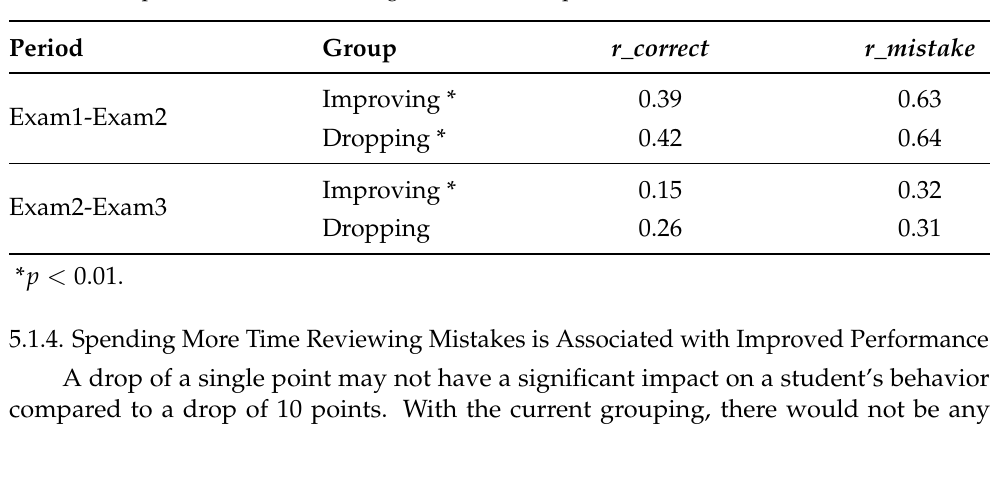
Table 4. Comparison of review coverage across the two